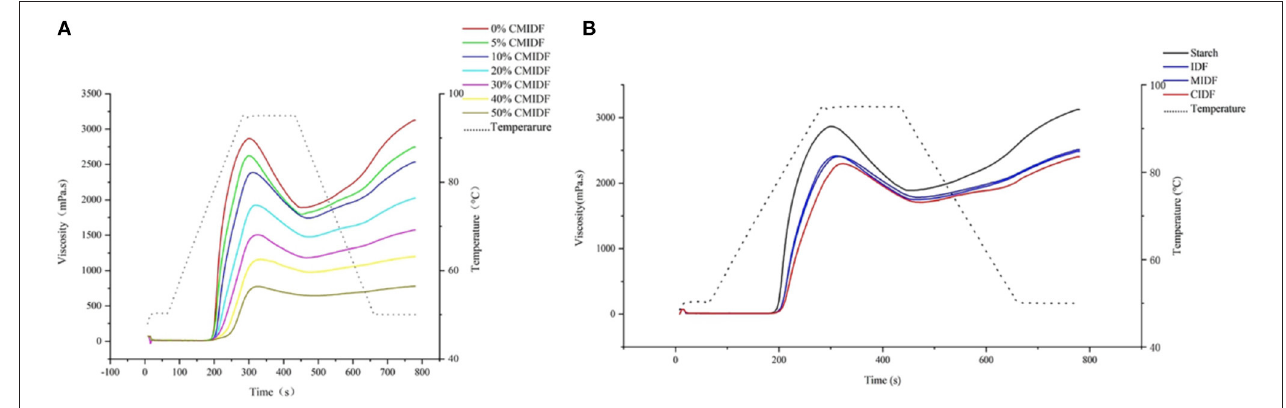
FIGURE 6 | Pasting curves of replacement of CS with insoluble dietary fibers. (A) Effect of different addition of CIDF. (B) Effect of addition with IDF, MIDF, and